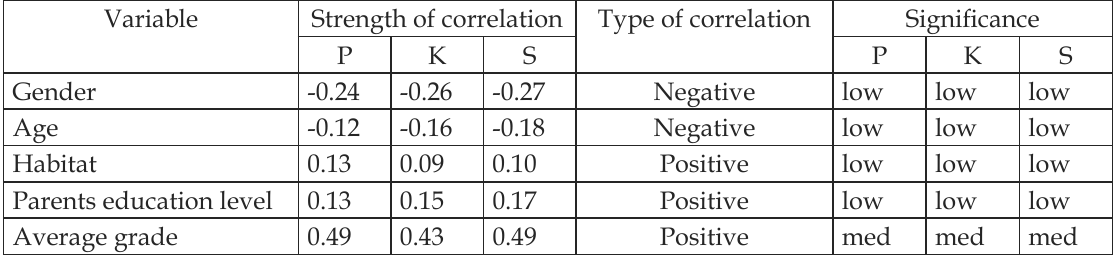
Table 2 . Correlations results (signi (cid:222) cance <0.05)